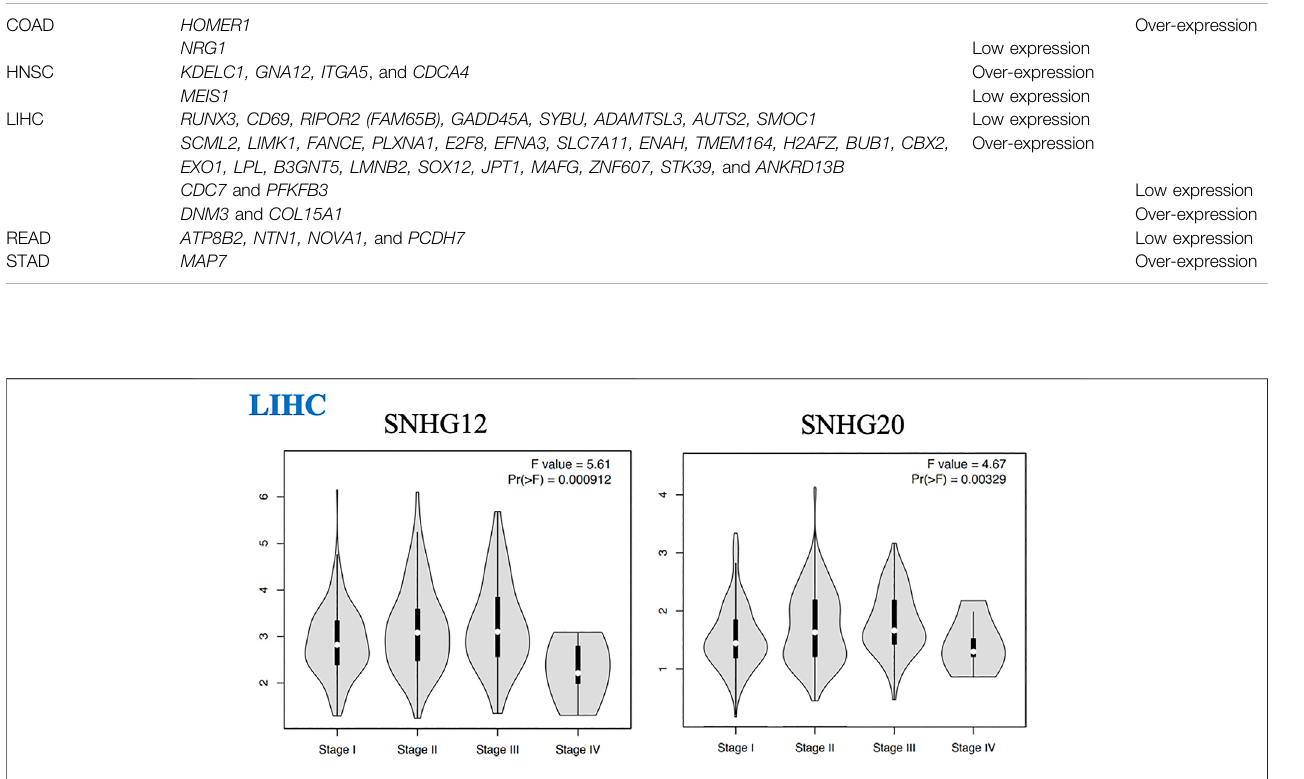
TABLE 3 | mRNAs as prognostic biomarkers identi fi ed in ceRNA networks of TCGA-GI cancers. TCGA cancer type